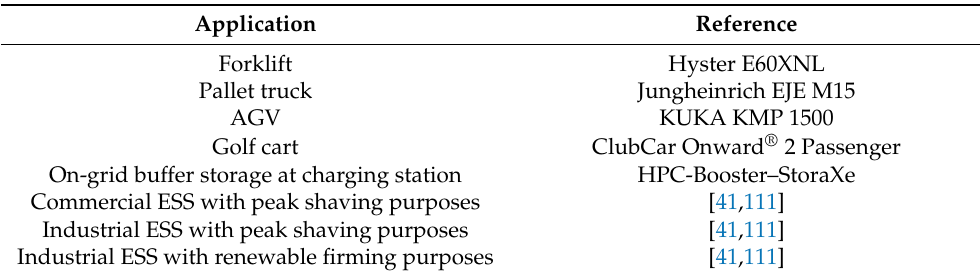
Table A1. List of references used to collect the absolute values of the parameters considered for the applications under investigation.